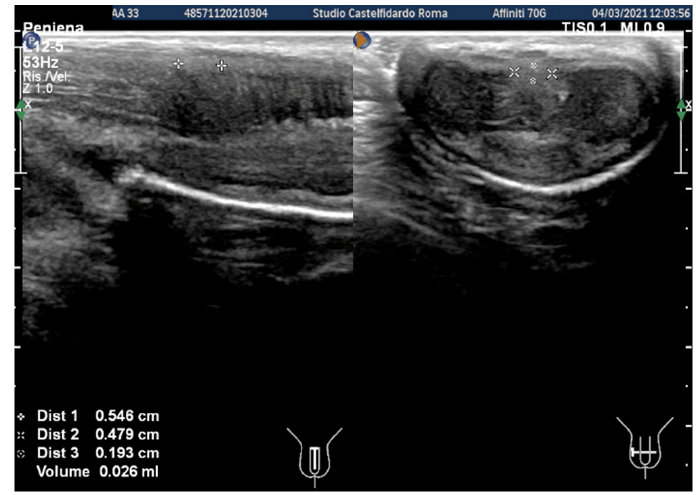
Figure 4. Ultrasonography of the penis after the second treatment cycle (longitudinal and transverse views).